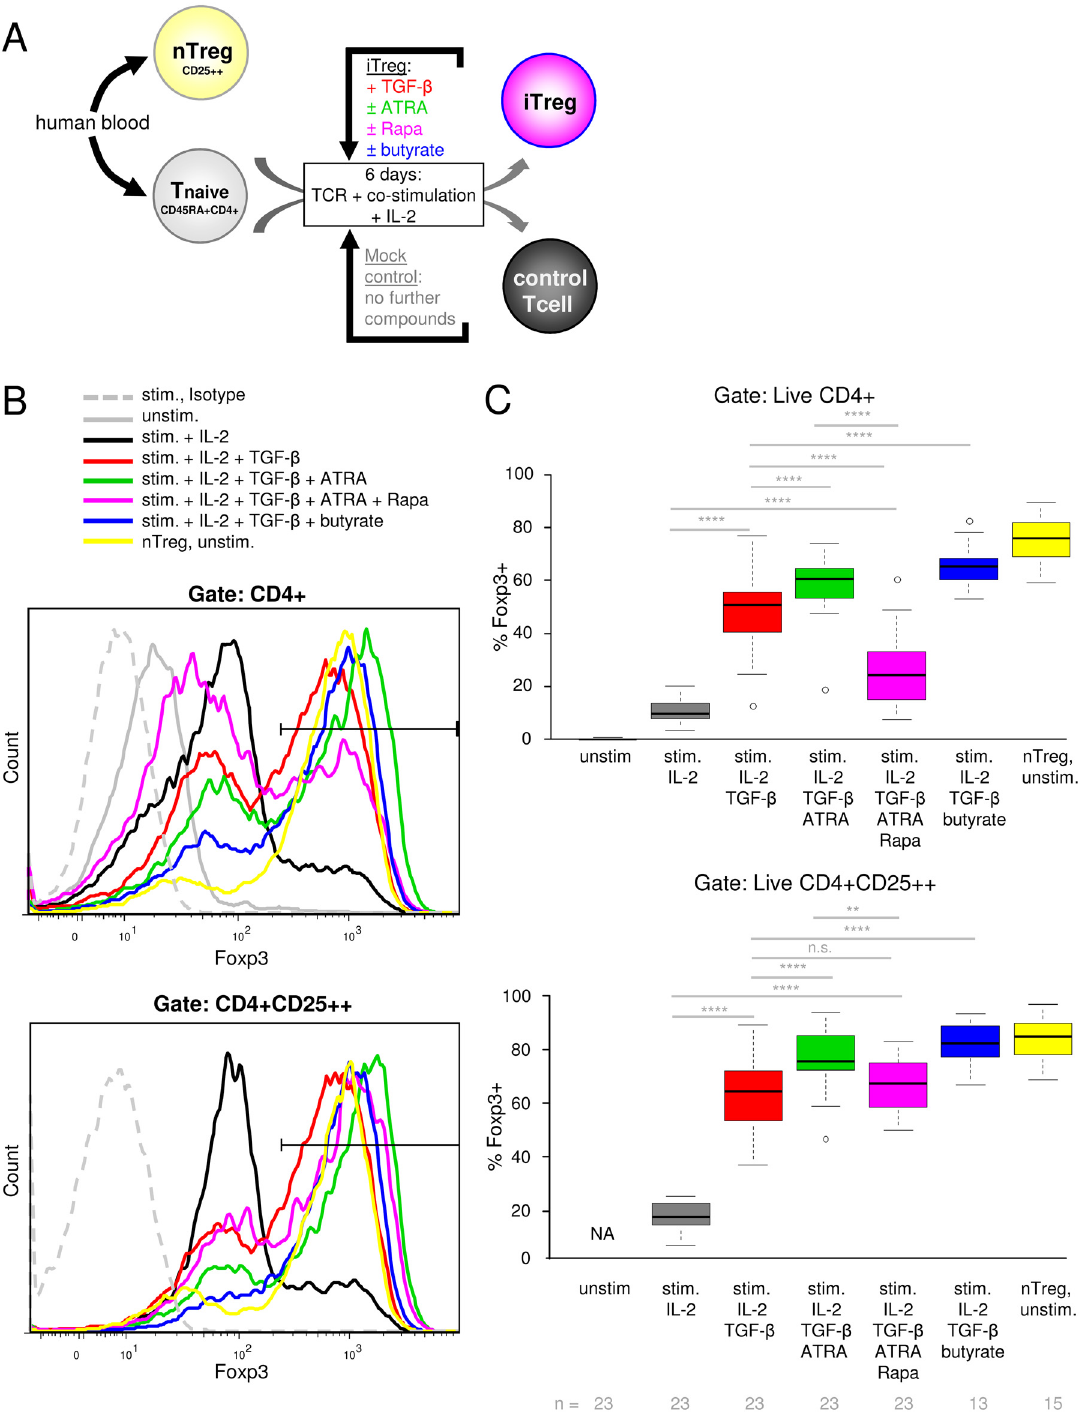
Fig 1. Foxp3 expression upon use of different protocols for human iTreg differentiation. (A) Experimental setup: Human na ï ve CD4 T cells were cultured for 6 days in serum-free medium under the indicated conditions. T cells were stimulated with anti-CD3 and anti-CD28 antibodies plus 100 U/ml IL-2 ( “ Stim. ” ). Where indicated, TGF- β 1, rapamycin (Rapa), all-trans retinoic acid (ATRA) or butyrate were added. nTreg ( ex vivo isolated peripheral blood CD25 high cells) were left unstimulated and used as positive control. (B) The histogram shows representative Foxp3 stainings for one donor, gated on CD4+ cells in the upper panel or on CD25++CD4+ cells in the lower panel. The striped line represents an isotype control staining (exemplarily shown for the condition “ stim. + IL-2 + TGF- β + ATRA + Rapa “ ). Unstim. = unstimulated na ï ve T cells. (C) The boxplot shows percentages of Foxp3 positive cells measured by FACS